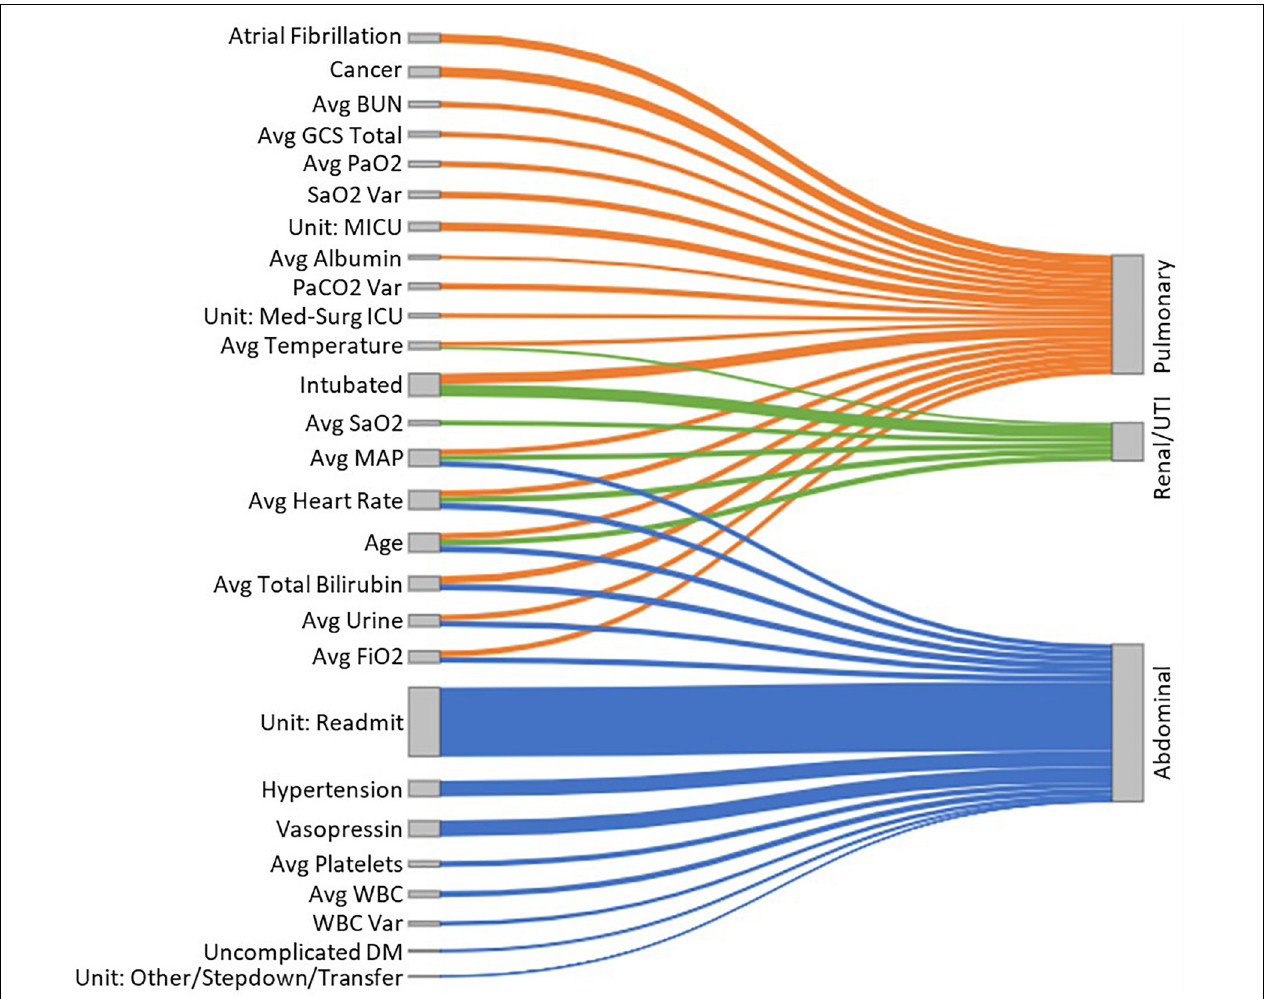
FIGURE 5 | A Sankey diagram representing the relationship between several clinical features (nodes on the left-hand side) and the sepsis groups (nodes on the right-hand side), with the link widths representing the absolute ORs proportional to the risk of in-hospital mortality for each of the sepsis